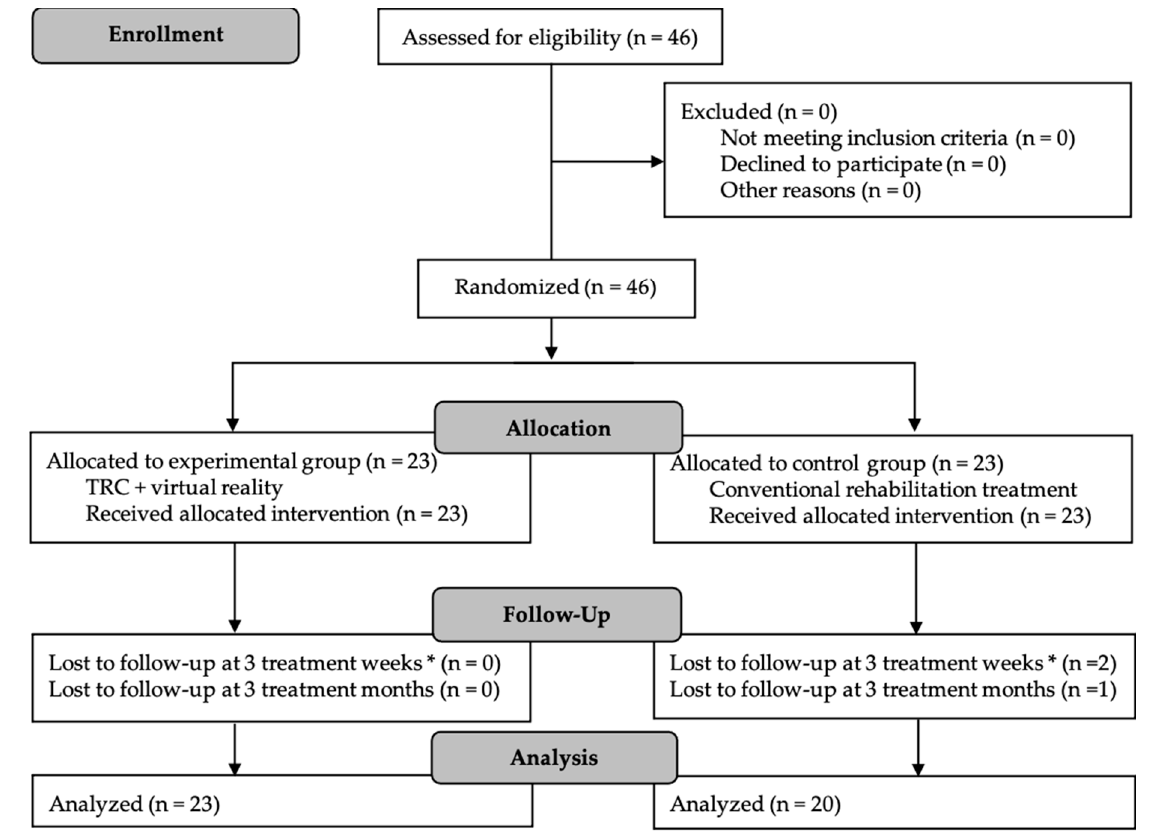
Figure 2. CONSORT Flow Diagram for participant recruitment, allocation, follow-up and analysis. TRC: conventional rehabilitation treatment. * Post-intervention evaluation. Table 1. Characteristics of the participants of both groups (n =